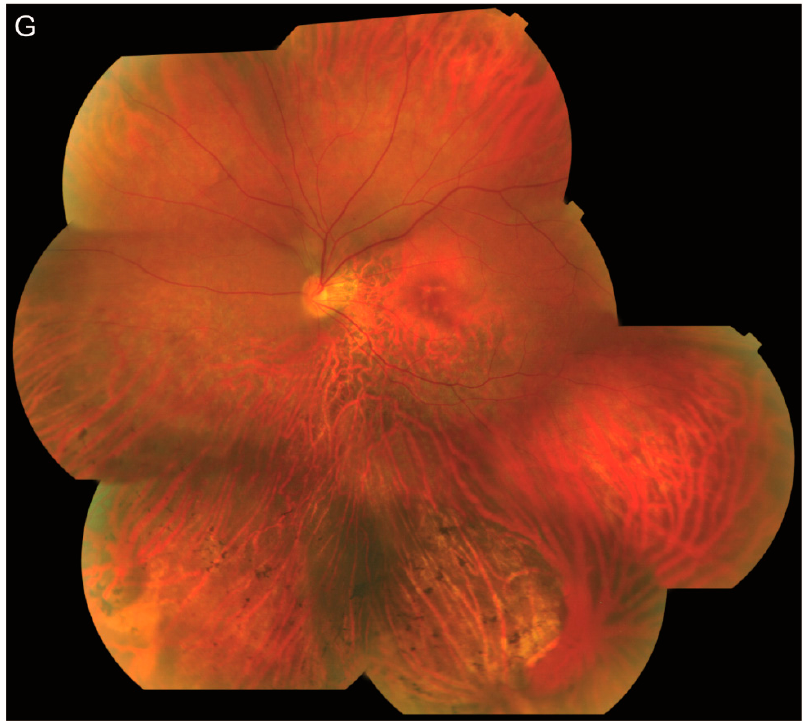
Figure 1. Retinal imaging of two individuals with CEP290 variants A–B, Clinical characteristics of patient II-1 of family A. ( A ) The fundus photograph showed a pink optic disc and mildly attenuated vessels. The retinal pigment epithelium (RPE) had a coarse-grained aspect in the posterior pole and mid-periphery, and a faintly recognizable foveola reflex with a subtle indication of bull’s eye-like maculopathy. ( B ) Fundus autofluorescence (FAF) revealed a relatively normal appearance. C–G, Clinical characteristics of patient II-2 of family A. ( C ) Fundoscopy displayed a pink, myopic optic disc, mildly attenuated vessels and subtle RPE changes in the macula with a faintly recognizable foveola reflex and thinning of the perimacular RPE. ( D ) Fundus autofluorescence of the right eye revealed a double hyperautofluorescent ring and hypoautofluorescent spots along and inferior to the inferior vascular arcade. ( E ) Optical coherence tomography (OCT) of the left eye displayed no discernible photoreceptor complexes at the macula, but recognizable outer retinal layers at the peripheral part of the scan. ( F ) Fundus autofluorescence of the left eye revealed a double faint hyperautofluorescent ring and hypoautofluorescent spots along and inferior of the inferior vascular arcade as well as in the macula. ( G ) A compilation of fundus photographs of the left eye of II-2 showed a pink and myopic optic disc and mildly attenuated vessels. A faintly recognizable foveola reflex was noted, as well as perifoveal RPE atrophy. Mild RPE changes in the superior quadrants and more pronounced RPE atrophy in inferior quadrants with bone-spicule pigmentations were